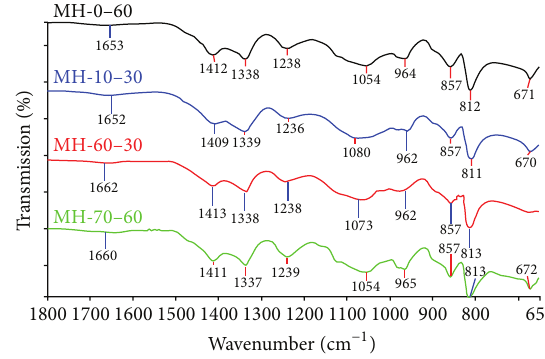
Figure 4: FT-IR spectrum of synthesized pure mcallisterite miner- als.